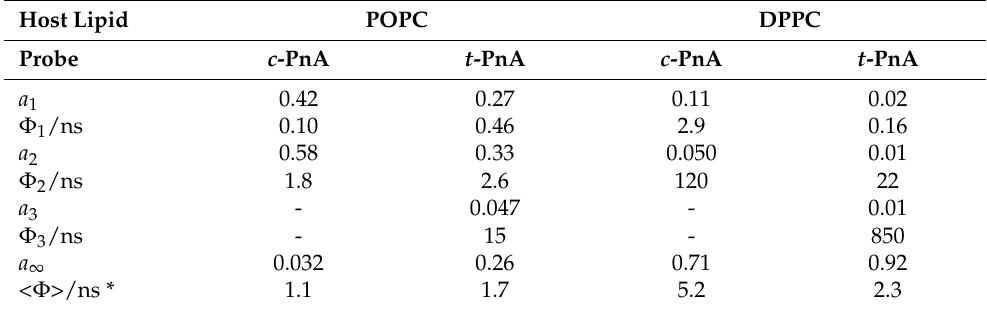
Table 1. Best fit parameters of Equation (2) to the calculated rotational